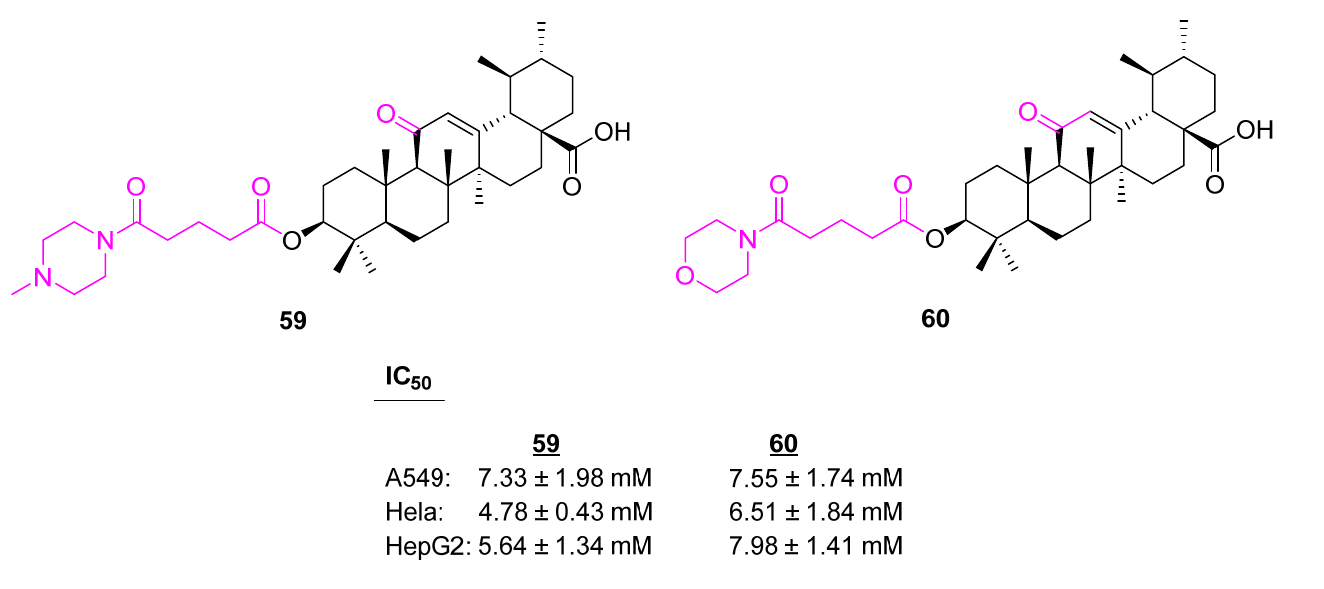
Figure 41. Structure of 59 , 60 .